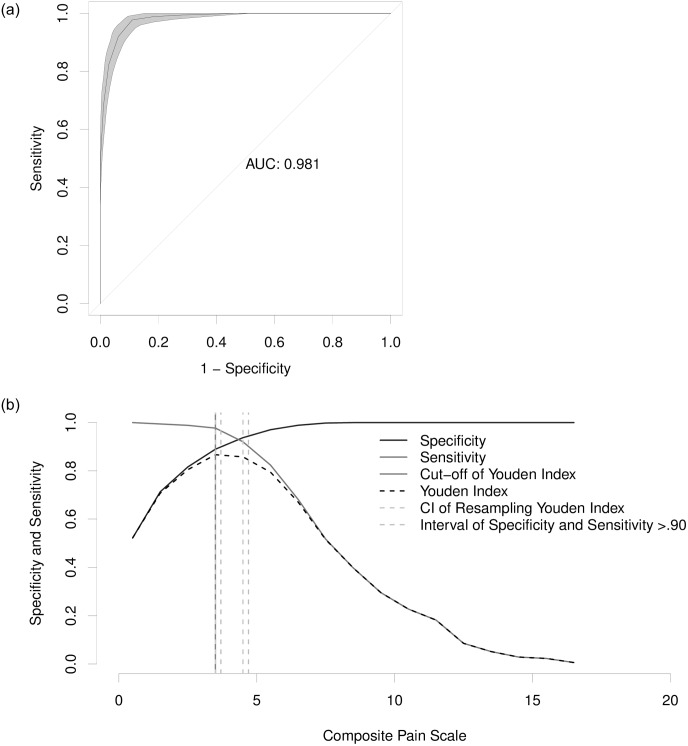
ROC curve and AUC (left) and two-graphic ROC curve with the diagnostic uncertainty zone for the UPAPS (right).Legend: UPAPS—UNESP-Botucatu pig composite acute pain scale. Receiver Operating Characteristic (ROC) curve with 95% confidence interval (CI) calculated from 1000 replications and area under the curve (AUC) (A—left). Two-graphic ROC curve, CI of the 1000 replications and of sensitivity and specificity > 0.90 applied to estimate the diagnostic uncertainty zone of the cut-off point using all moments of pain assessment scored by all observers in the 2nd evaluation phase, according to the Youden index for the UPAPS (B—right).